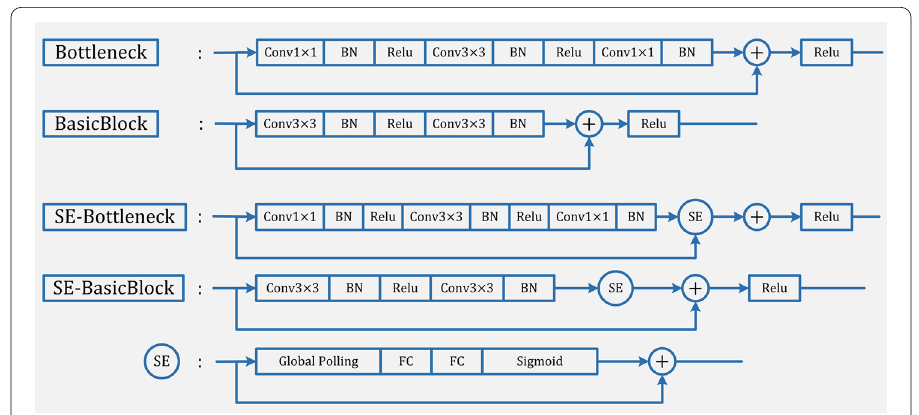
Fig. 2 Architecture of SENet. BasicBlock and Bottleneck are original Residual modules. SE-BasicBlock and SE-Bottleneck is obtained by embedding the SE block into the residual